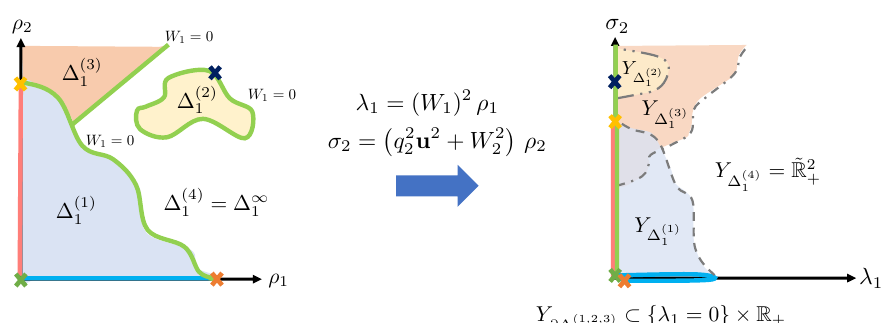
Figure 1 . The domain decomposition and mapping under reparameterization (3.29) for (cid:10) I =1 of the N f = 2 theory. The angular part is projected out to make the drawing simple. The image of boundary is di(cid:11)erent from the boundary of the image, i.e., Y